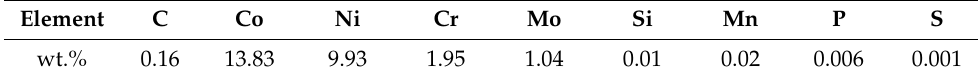
Table 1. Chemical composition (wt.%) of AF1410 steel.